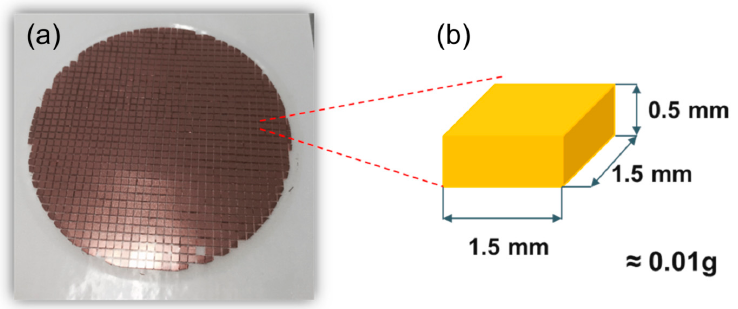
Figure 2. Cu wafer: ( a ) polished image and ( b ) size of diced one.